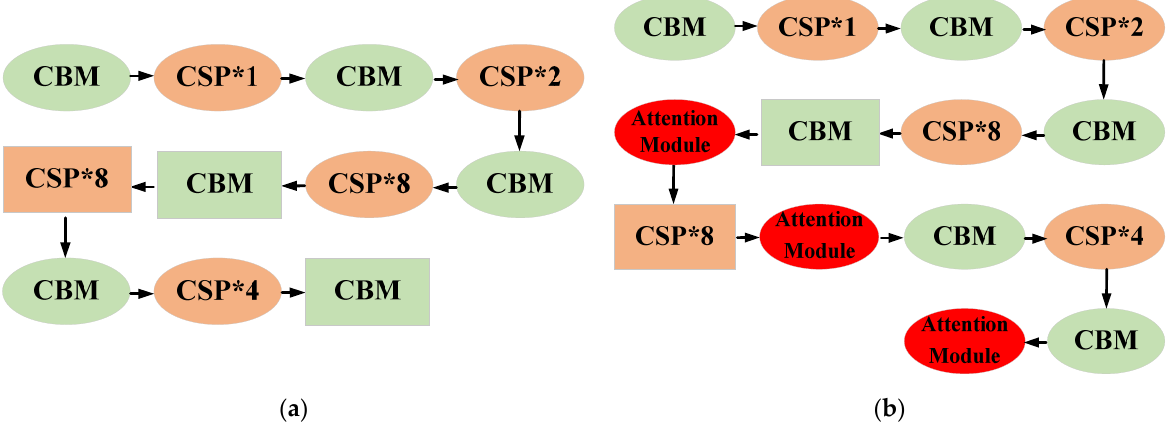
Figure 15. ( a ) The architecture of original YOLOv4; ( b ) improved YOLOv4 with a tt ention modules.